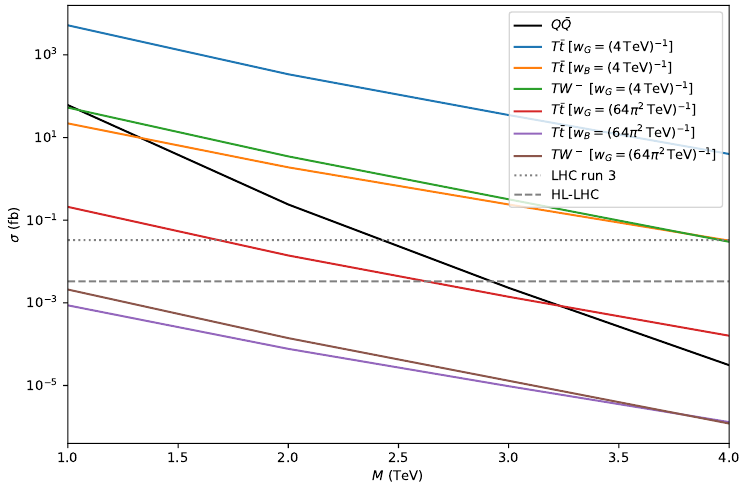
Figure 5 . Single production with Q(cid:27) (cid:22)(cid:23) qF (cid:22)(cid:23) -type operators.